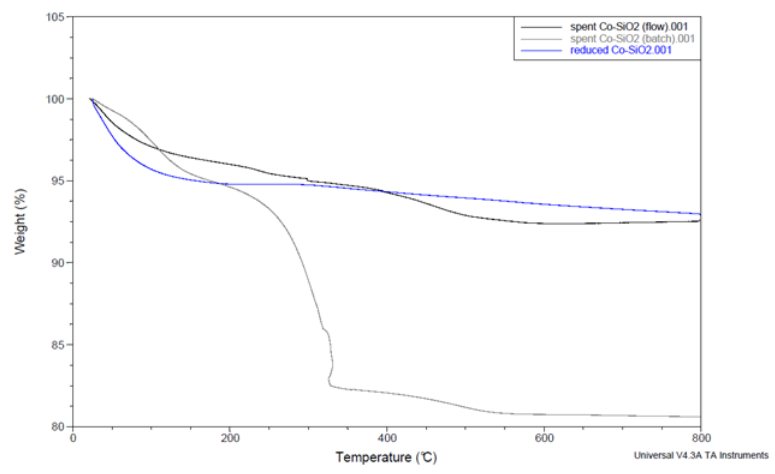
Figure 4. TGA analysis of the reduced Co / SiO 2 catalyst before reaction and after reaction under batch and flow conditions.